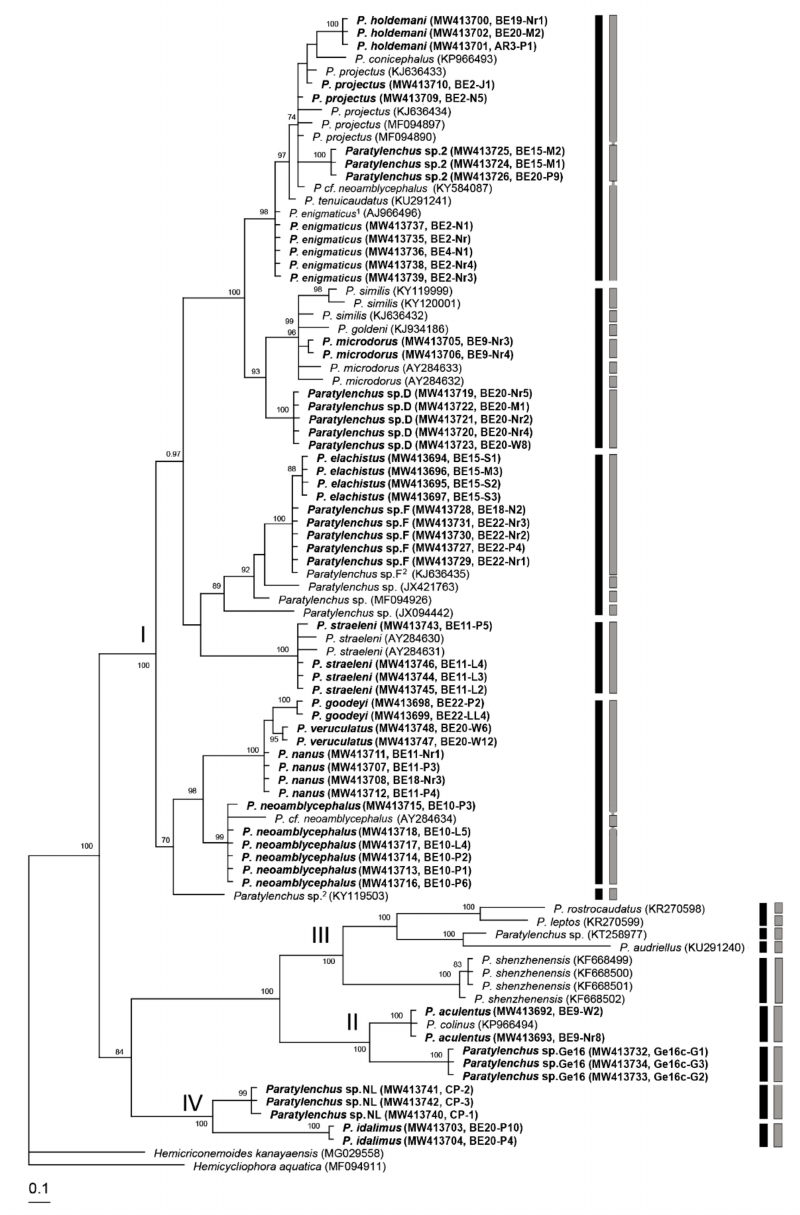
Figure 18. Phylogenetic relationships within populations and species of Paratylenchus , as inferred from Bayesian analysis using the 18S rRNA gene sequence dataset with the GTR + I + G model. Posterior probability more than 70% is given for appropriate clades. Newly obtained sequences are indicated in bold. 1 = originally identified as P. dianthus and 2 = originally identified as P. nanus . Black and grey bars represent species boundaries estimated by GMYC and bPTP methods,